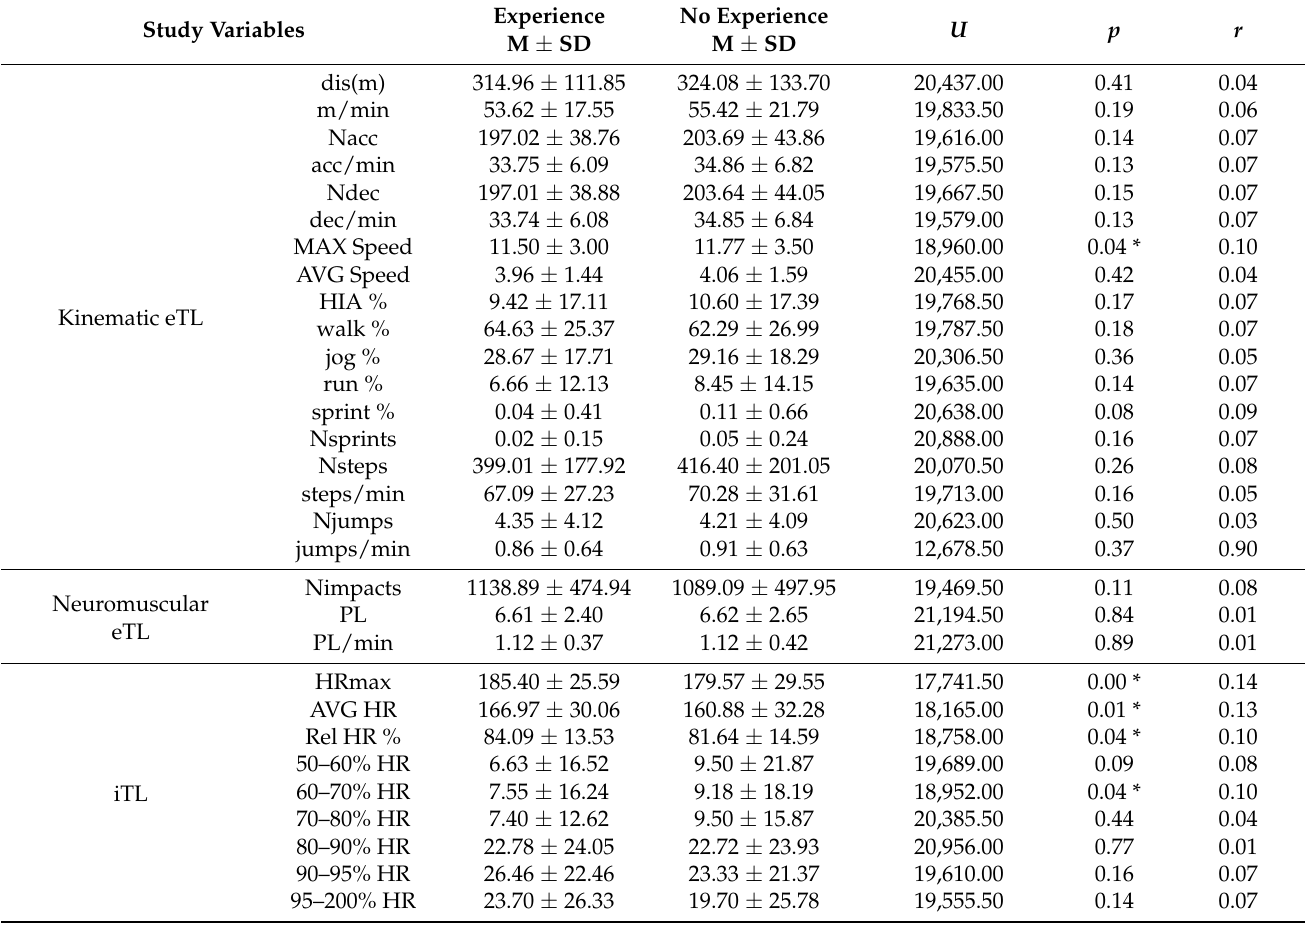
Table 3. Results of the assessment tests (pre-test/post-test) according to prior experience. Study